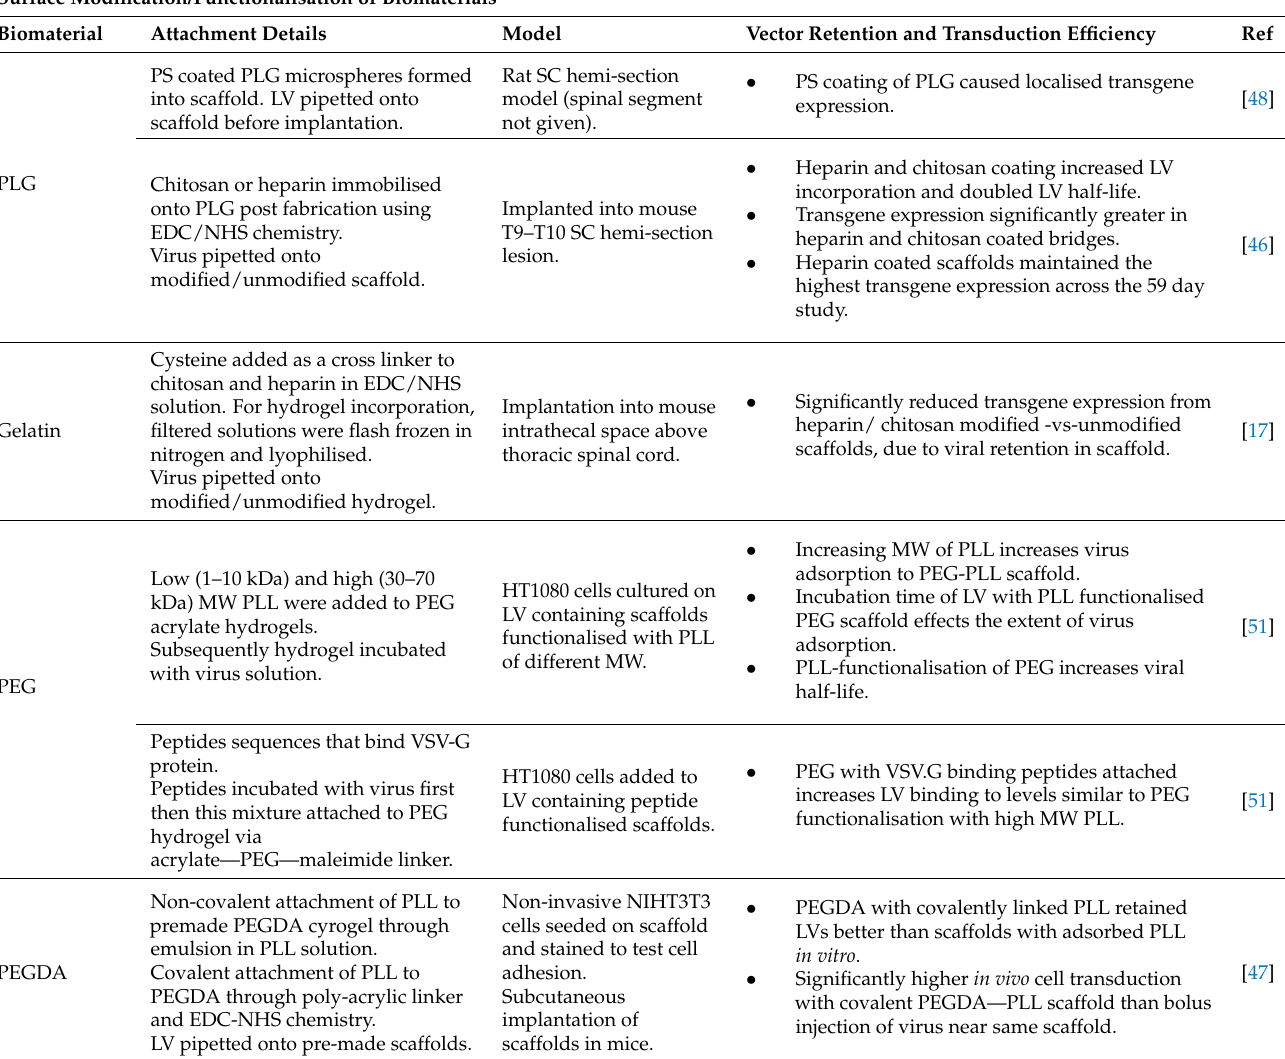
Table 2. Studies using surface modification/ functionalisation for LV delivery on biomaterials. PLG; poly(lactide-co- glycolide), PEG; Polyethylene (glycol), PEGDA; Polyethylene (glycol) diacrylate, PLL; poly- L -lysine, PS; phosphatidylserine, MW; Molecular Weight, SC; spinal